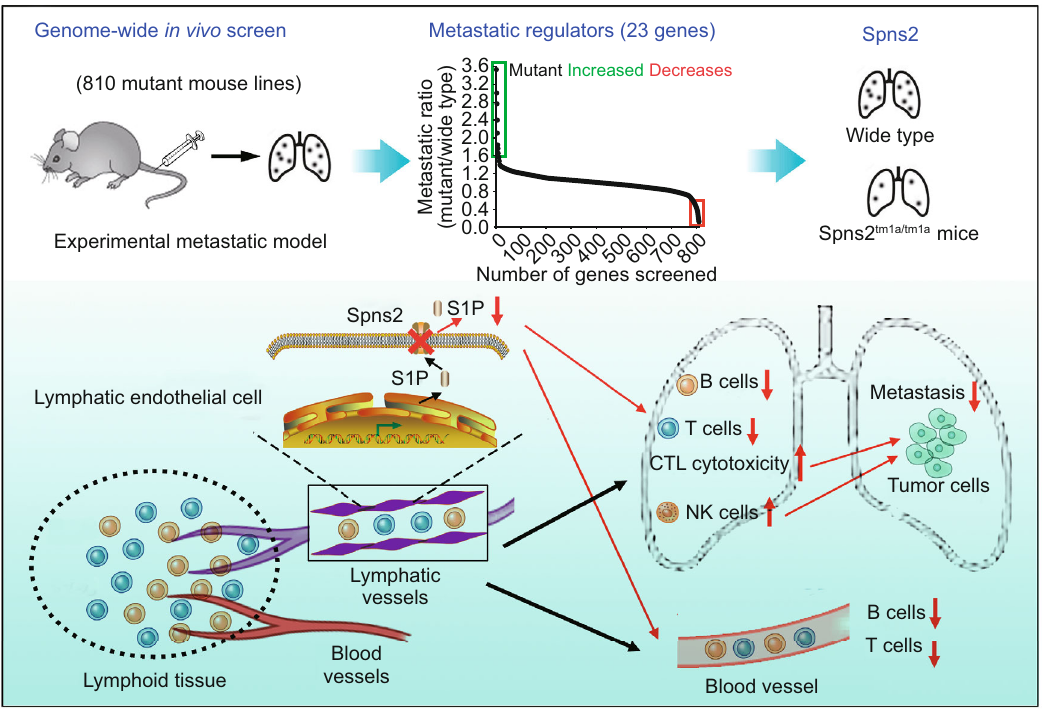
Figure 1. Genome-wide in vivo screen identi fi es host Spns2 in promoting cancer metastasis. Adams and colleagues identify 23 novel genes in host microenvironment to regulate metastasis by genome-wide in vivo screen using an experimental metastasis assay. Host Spns2 is demonstrated as an important metastatic promoter via modulating lymphocyte traf fi cking. CTL, cytotoxic T lymphocyte; NK cell, natural killer cell; S1P, sphingosine-1-phosphate; Spns2, S1P transporter spinster